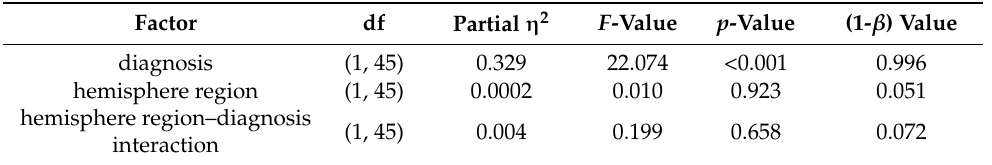
Table 1. Main effect of diagnosis, main effect of hemisphere, and hemisphere–diagnosis interaction revealed by two-way ANOVA for short-range HbO 2